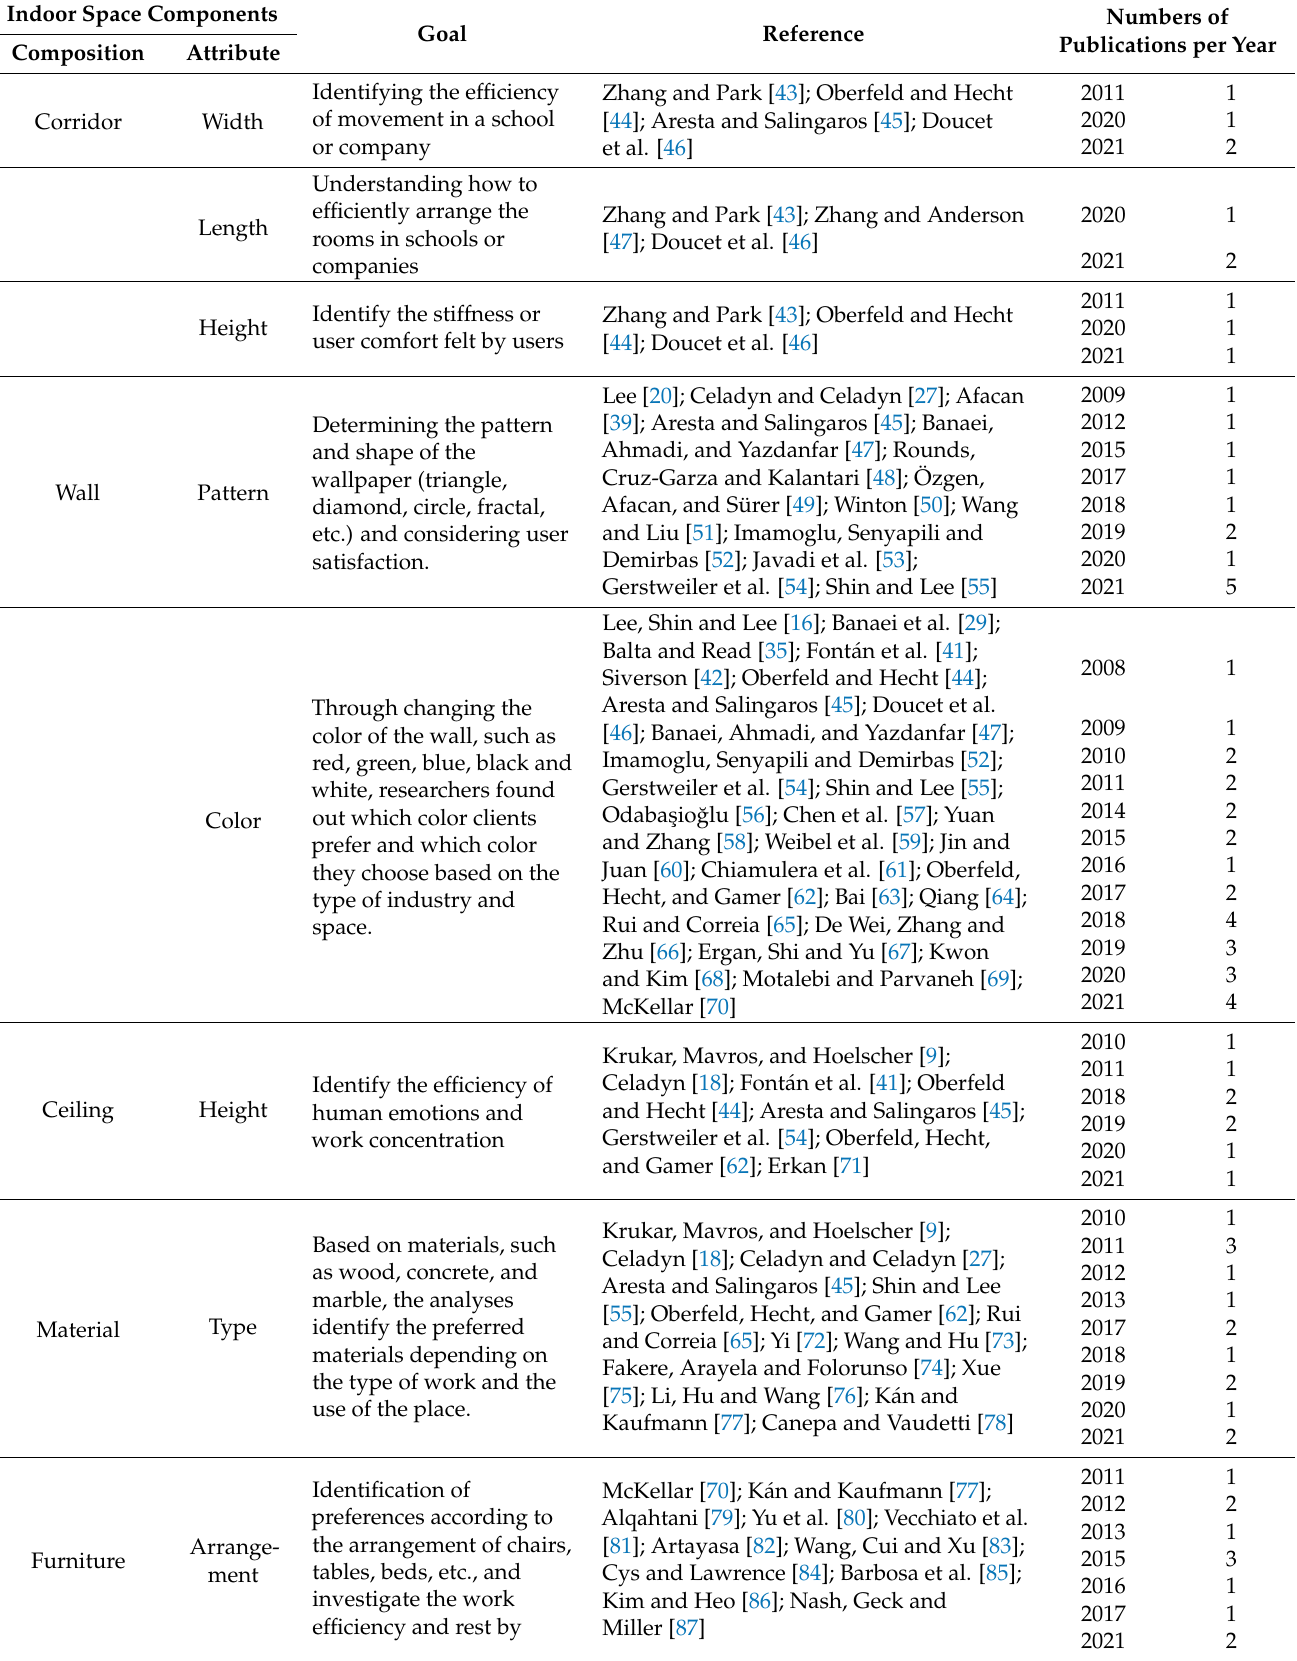
Table 3. Summary of the literature review of indoor space